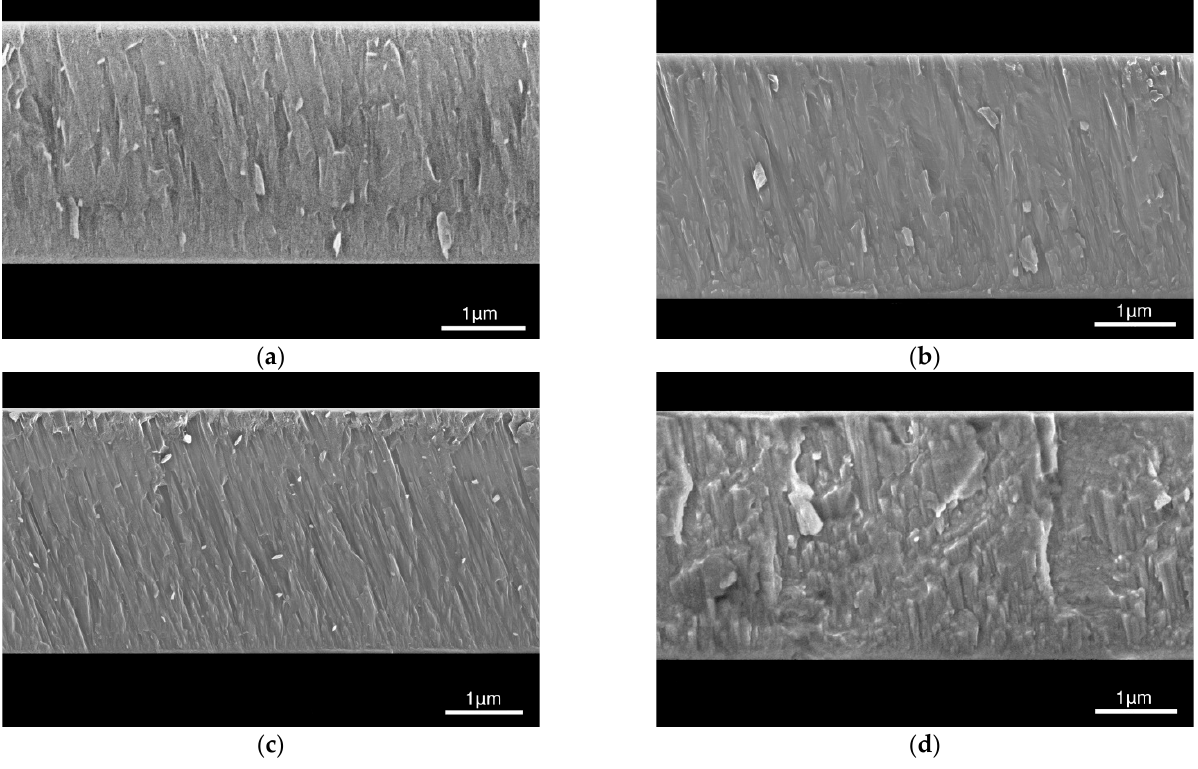
Figure 3. Cross-sectional SEM micrographs of Ti-Al-Ta-N coatings obtained in different sputtering modes: ( a ) mode 1, ( b ) mode 2, ( c ) mode 3, and ( d ) mode 4.